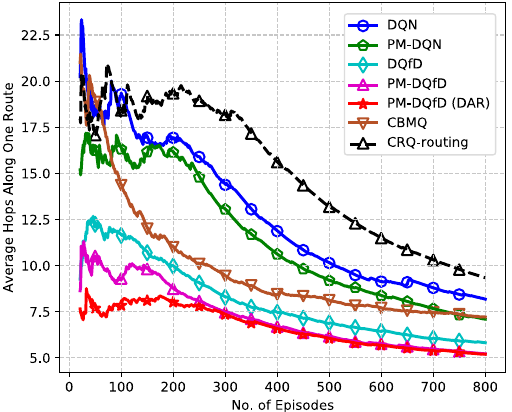
Figure 10. Average number of hops along the path versus number of episodes.